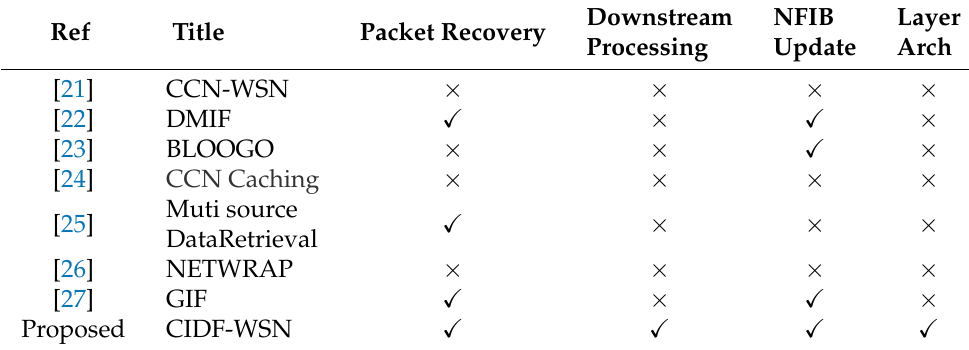
Table 1. Summary of Related